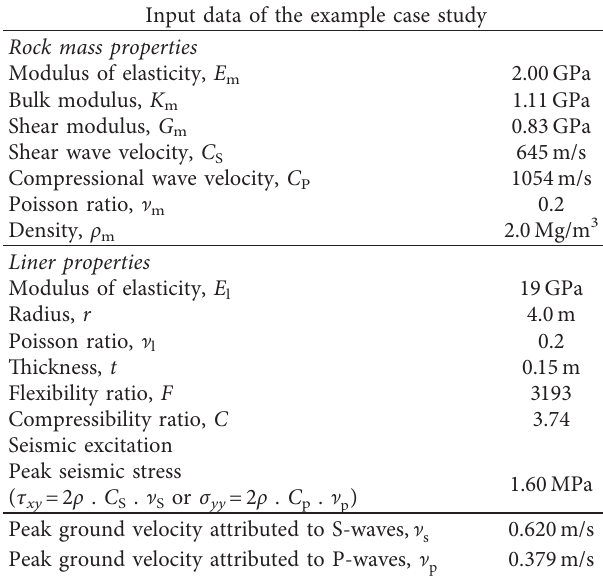
Table 1: Elastic properties of the rock mass, tunnel lining, and seismic excitation [23].